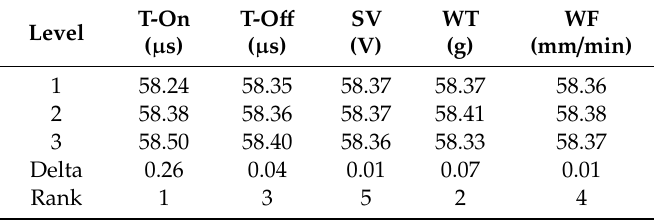
Table 9. S / N ratio analysis of MCW (Larger is